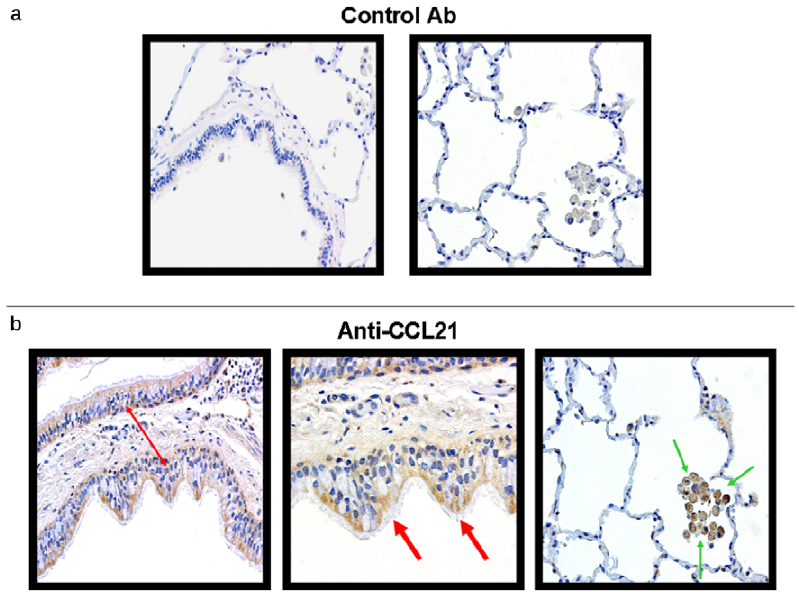
Figure 6. Histopathology demonstrating CCL21 production in healthy lung allograft. Representative immunohistochemistry for (a) control antibody and (b) CCR7 ligand CCL21 on healthy lung allograft biopsy tissue. CCL21 protein expression is found in bronchial epithelial cells (red arrows) and alveolar macrophages (green arrows). Panels were photographed at 200 6 and 400 6 magnification.